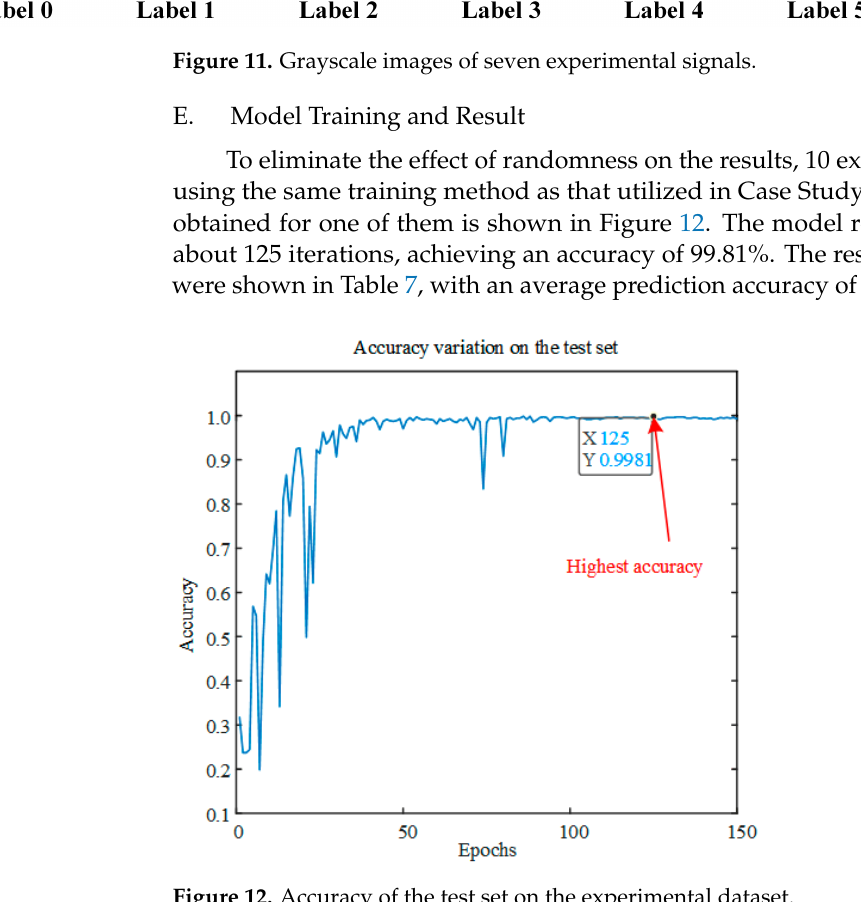
Figure 12. Accuracy of the test set on the experimental dataset.